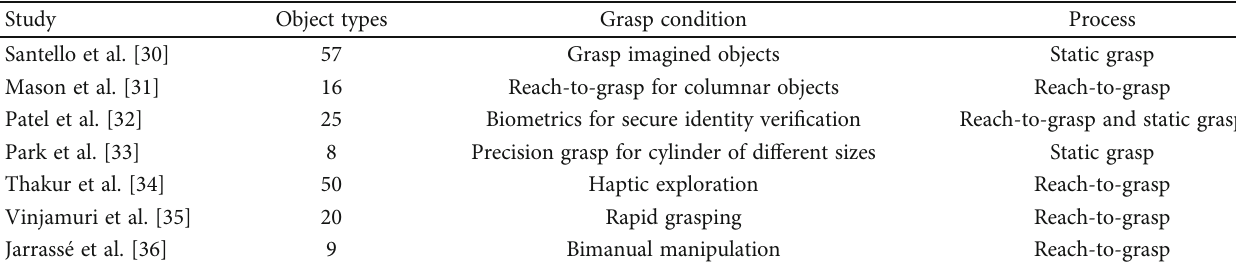
Table 3: Summary of hand kinematic synergies in previous